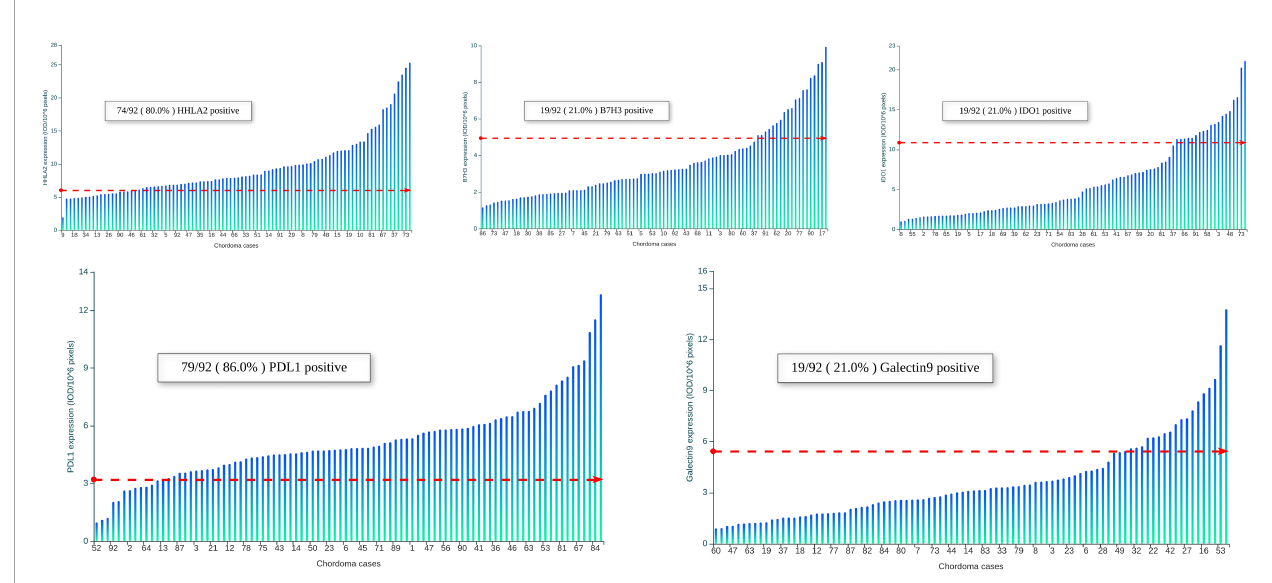
FIGURE 5 | Distribution of HHLA2, B7H3, IDO-1, PD-L1 and Galectin-9 in 92 spinal chordoma samples. Scores are expressed as arbitrary units of fl uorescence, and the dashed red line indicates the signal detection threshold determined as described in the methods section. The proportion of cases with detectable target signals is indicated within each chart.